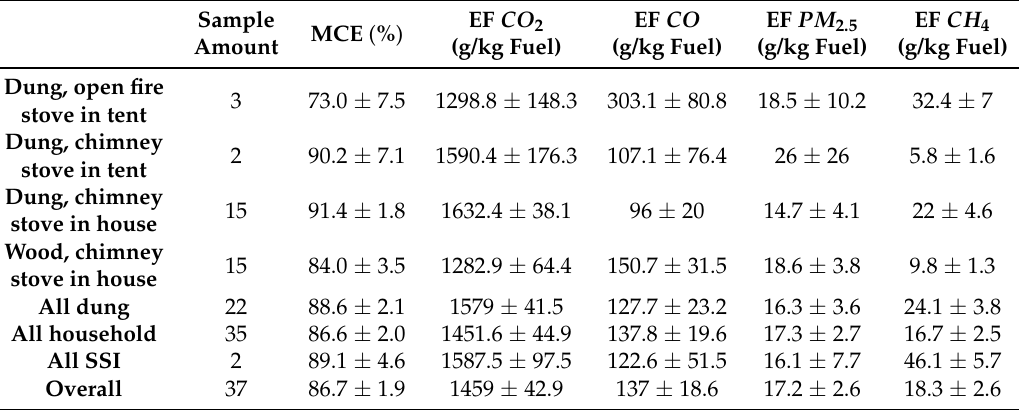
Figure 4. Typical real-time emission in Tibet, top: Nam Co; bottom: Linzhi. Table 2. Statistical summary for the Tibet